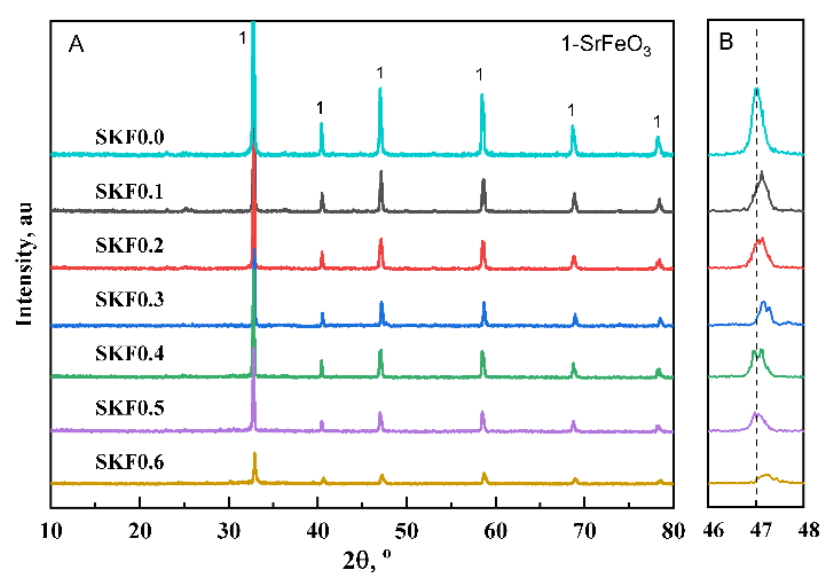
Figure 2. XRD patterns of the as-prepared SKFx (x = 0–0.6) catalysts: ( A ) full pattern; ( B ) at 2 θ = 46–48°.